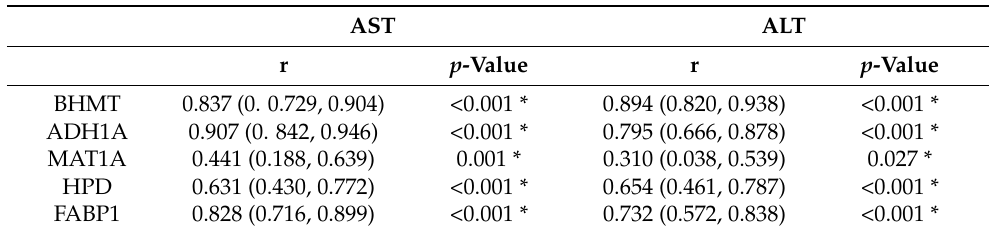
Table 4. Correlation with 95% confidence interval between plasma abundance of upregulated intracellular hepatic proteins associated with the EoT group and serum